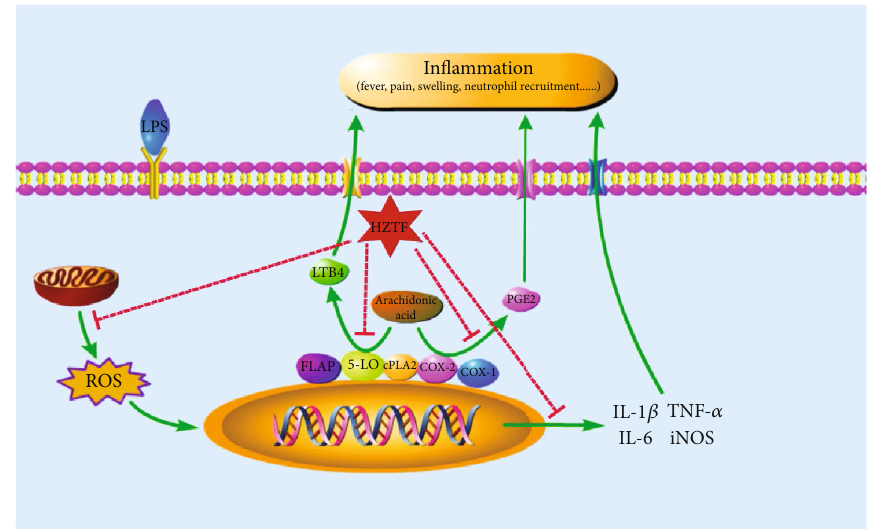
Figure 9: Overview of mechanism of HZTF on